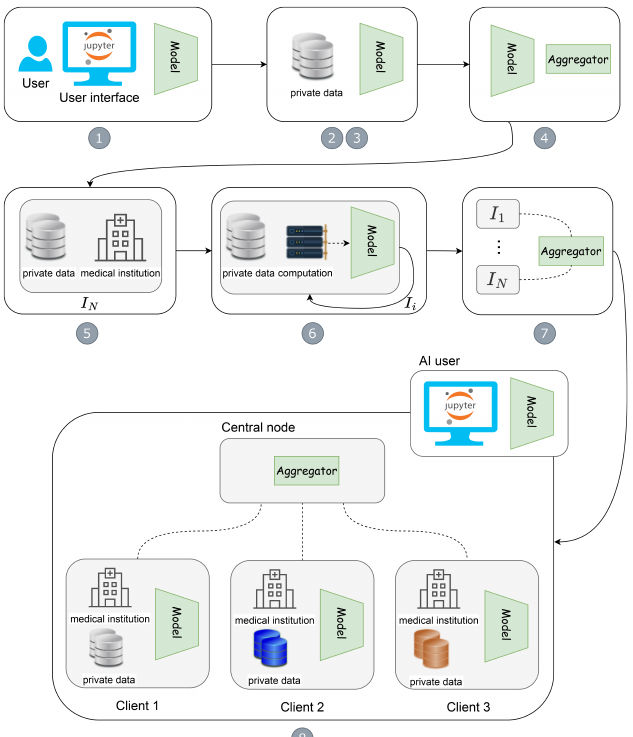
Figure 3. Step-by-step implementation of the federated pipeline, the starting point being a local institution with their corresponding local data, and the result being the